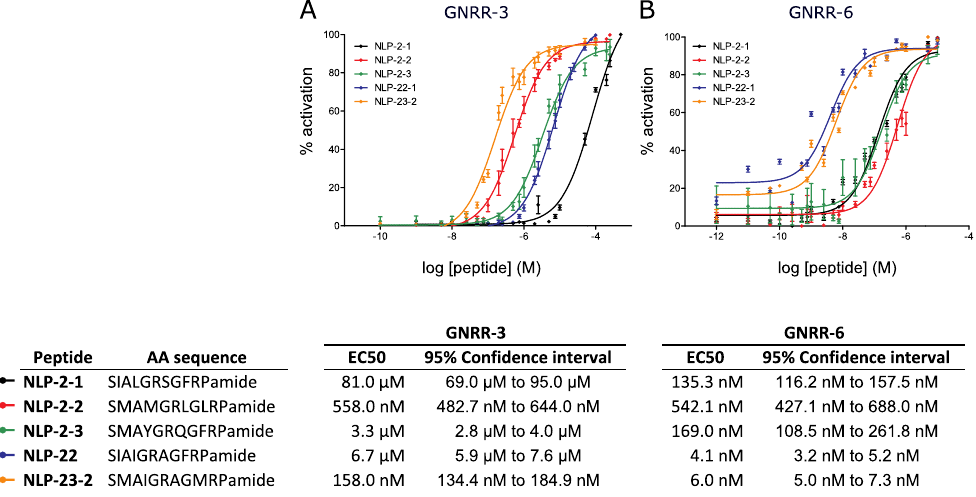
Figure 2. NLP-2, NLP-22, and NLP-23 peptides activate GNRR-3 and GNRR-6 in vitro . Dose-response curves for GNRR-3 ( A ) and GNRR-6 ( B ) co-expressed in CHO cells with a promiscuous G α 16 protein are shown as relative (%) to the highest value (100% activation) after normalization to the total calcium response. Each data point represents the mean ± SEM of N = 5–7 replicates for each peptide. ( C ) Amino acid (AA) sequences of RPamide neuropeptides activating GNRR-3 and GNRR-6 with their respective mean EC 50 values and 95% Confidence